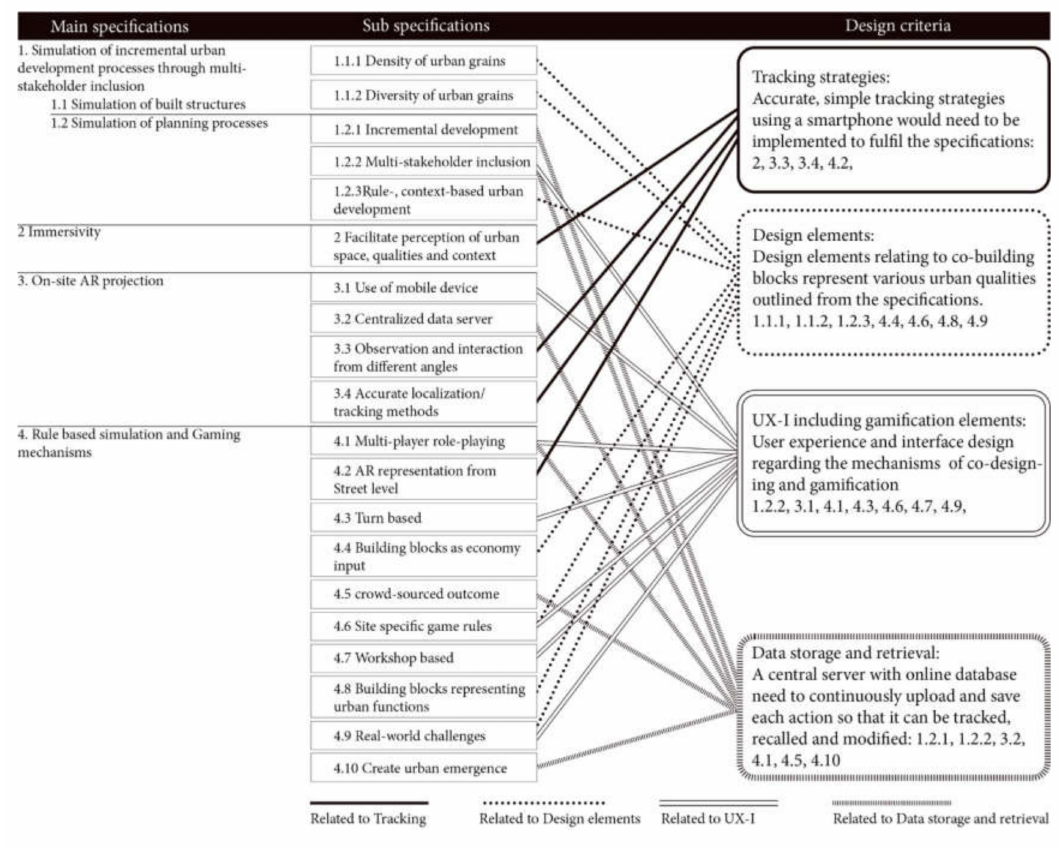
Figure 1. Simplification and grouping of the specifications according to [15] into design criteria for the outdoor mobile augmented reality (MAR). Data storage and retrieval is not accounted for in this